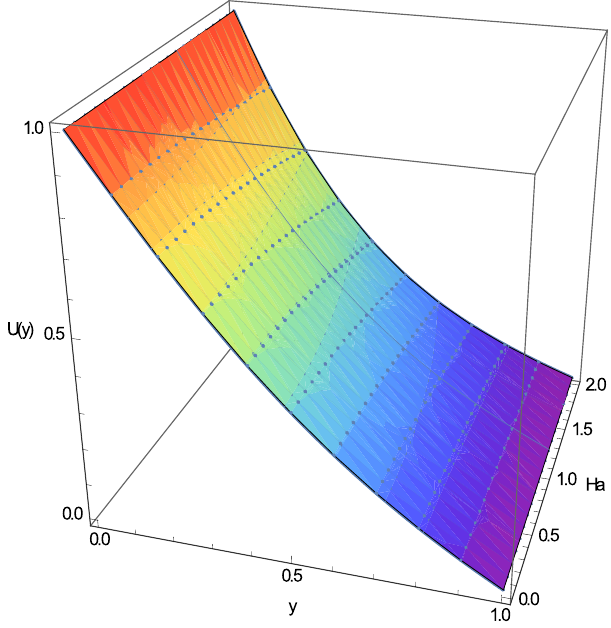
Figure 5. The effect of the increase of Ha on U for the case Re = 1—three dimensional plot.